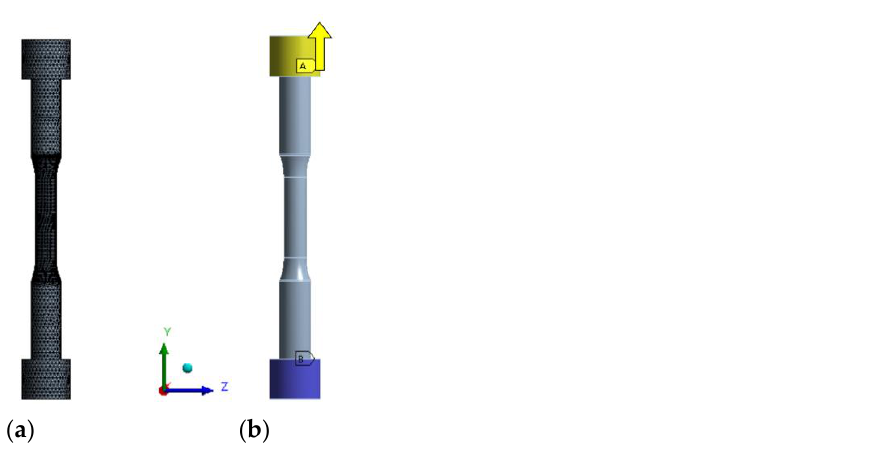
11 of 21 Figure 18. T he S–N curve comparison graph of SKD61. 5. Finite Element Analysis of Fatigue Test Specimens 5.1. Finite Element Modeling of Fatigue Test Specimens For finite element analysis of the specimen, finite element modeling was performed